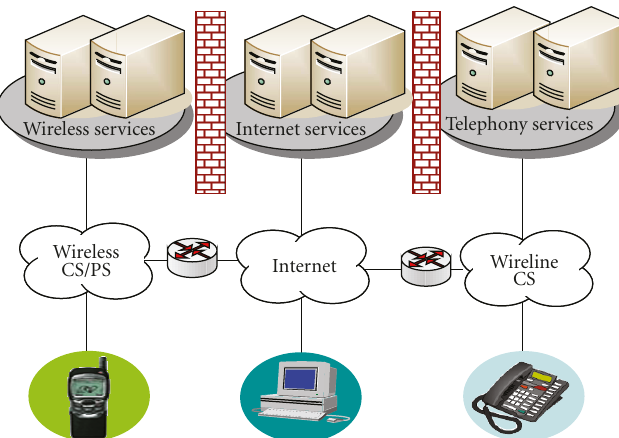
Figure 2: Traditional vertical service platform.